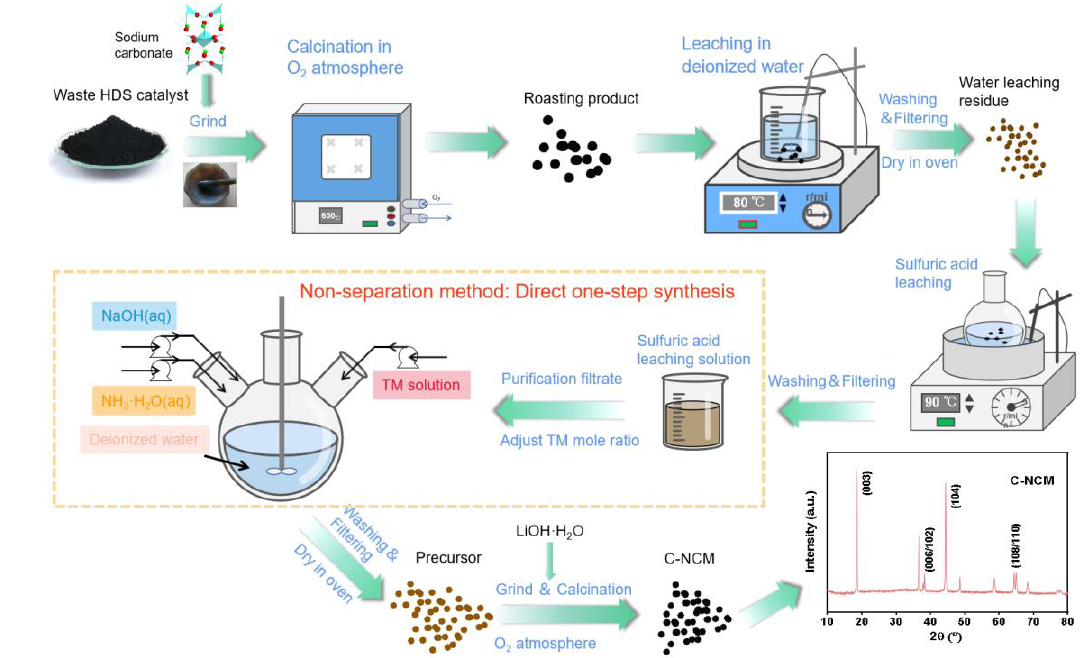
Figure 1. The process flow diagram of waste HDS catalyst recovery.